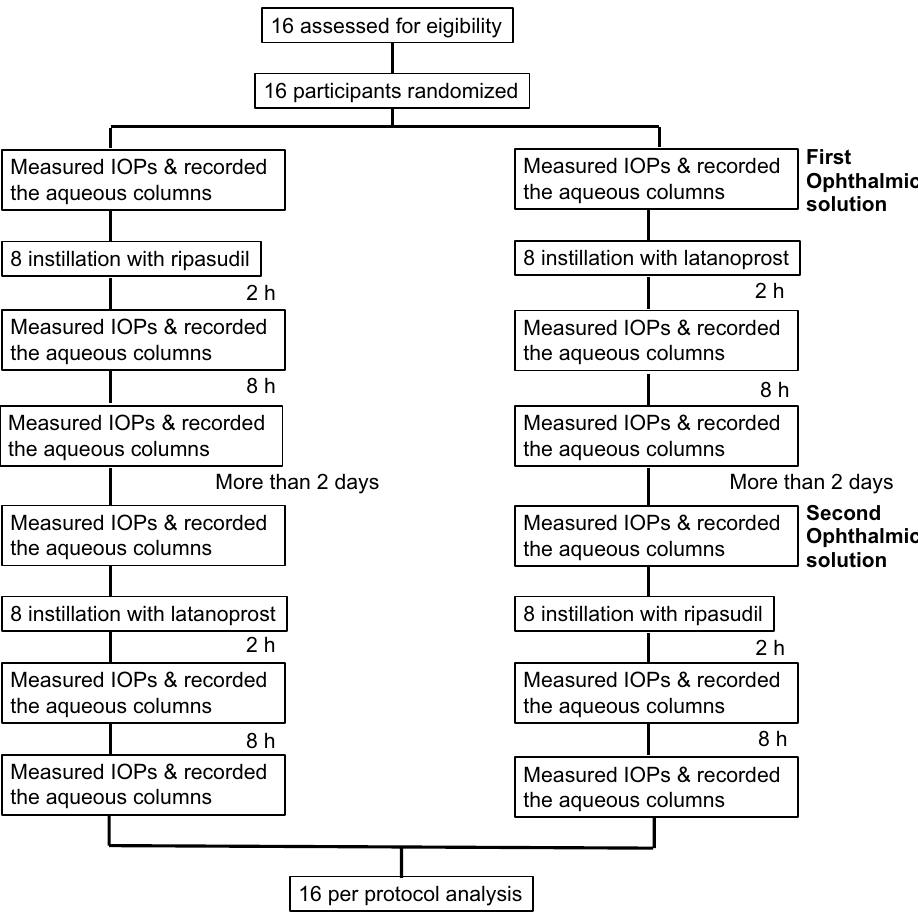
Figure 1. Flowchart of participant progress in this study. IOP, intraocular